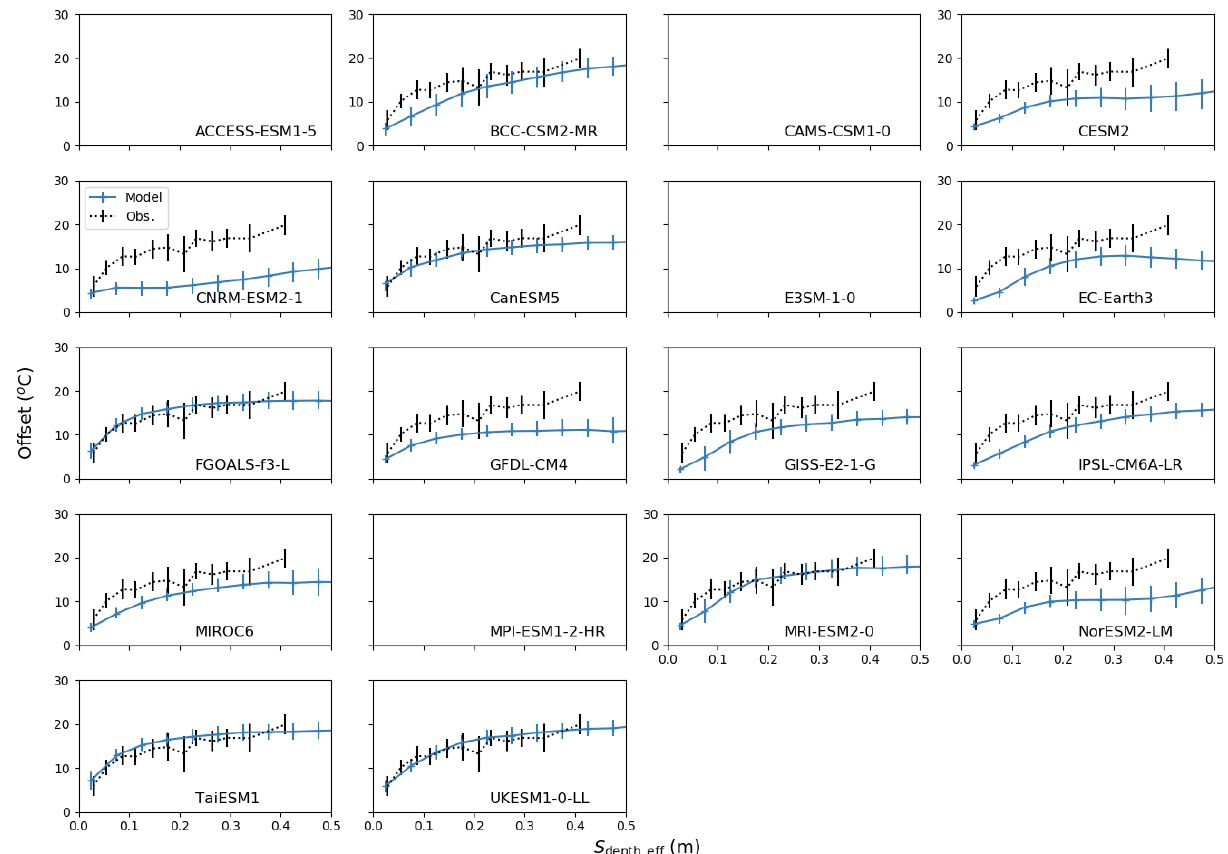
Figure 7. Differences between the air and soil temperature at 0.2m for the winter as a function of S depth,eff . Only grid cells or sites where the winter air temperature is between − 25 and − 15 ◦ C are shown. The climatological period of 1995–2014 is shown for the CMIP6 models. The blue points with the error bars are the model data, and the dotted black lines and error bars are the observations derived using the data from Zhang et al. (2018). In addition, only the models where snow depths are available from the CMIP archives are shown.